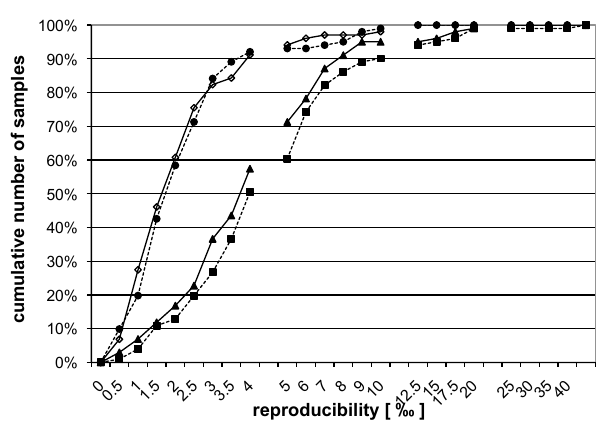
Fig. 8. Cumulative number of samples (in percent) with an re- producibility better than a given level. The line breaks indicate a change of the x-axis scale. ♦ SPI, (cid:4) “Individual BDG”, N “Me- dian BGD”, • “TimeBased BGD